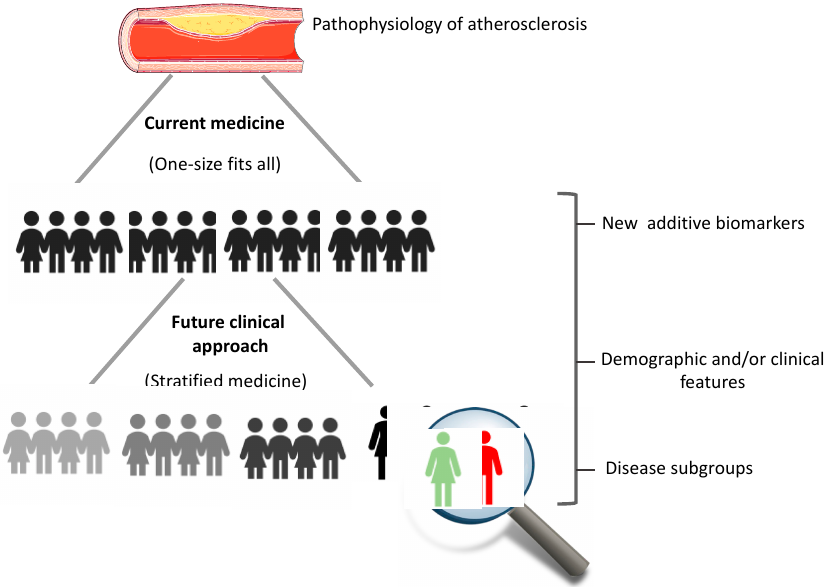
Figure 2. Evolution from current to future medicine. Stratification and revised classification towards a more personalized approach to clinical practice should occur through a growing understanding of molecular and biological mechanisms.